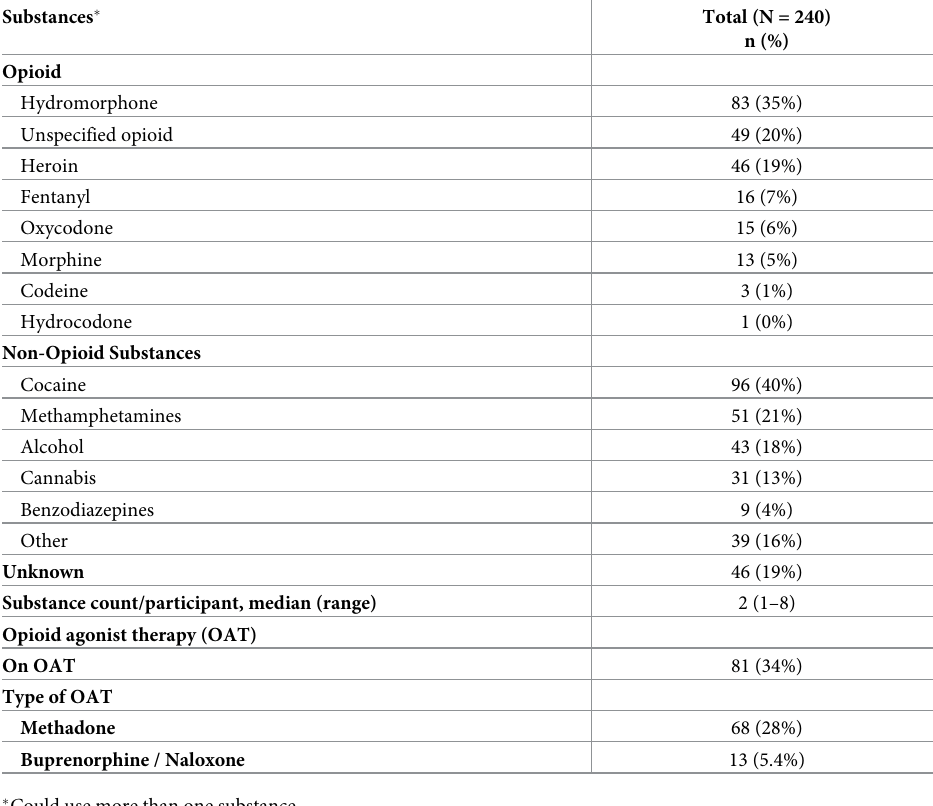
Table 4. Substances used and OAT (Opioid agonist therapy). Substances